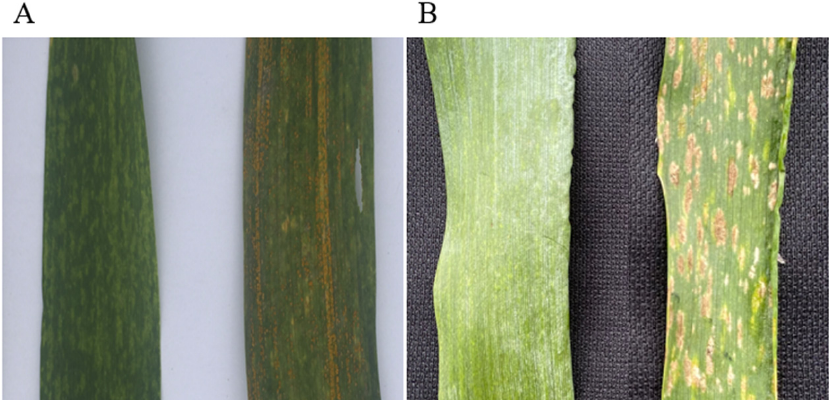
Resistance to stripe rust; ( B ) Resistance to powdery mildew. Left: 117-6, right: CN25.